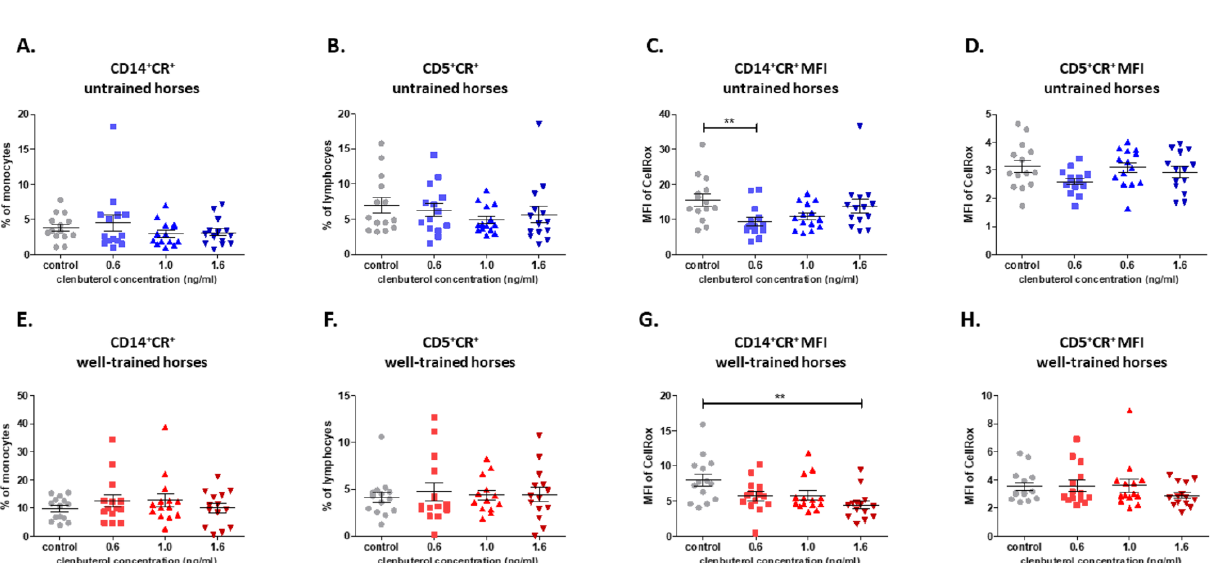
Figure 4. Graphic representation showing percentages of positive cells: CD14+CR+ ( A , E ), CD5+CR+ ( B , F ) gated from total lymphocytes/monocytes and median fluorescent intensity of CR (CellRox) in CD14+ ( C , G ) and CD5+ ( D , H ) cells. Each dot represents one individual horse ( n = 28) and means ± SEM (standard error of the mean) are presented. Significance levels are: ** p < 0.01.